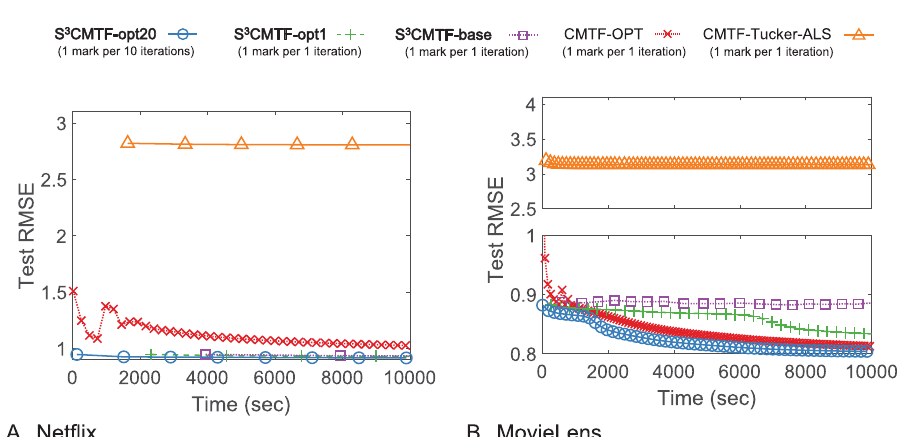
Fig 4. Test RMSE of S 3 CMTF and other CMTF methods over iterations. S 3 CMTF-opt20 shows the best convergence rate and accuracy.